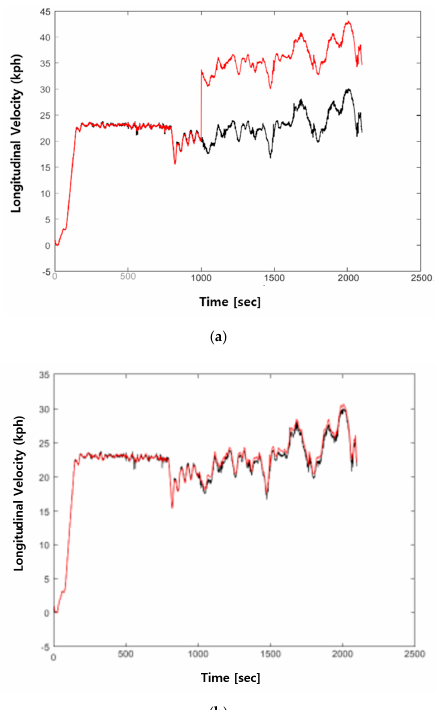
Figure 11. Longitudinal velocity of host vehicle. ( a ) Velocity of host vehicle without fault-detection algorithm; ( b ) velocity of host vehicle with fault-detection algorithm. algorithm; ( b ) velocity of host vehicle with fault-detection